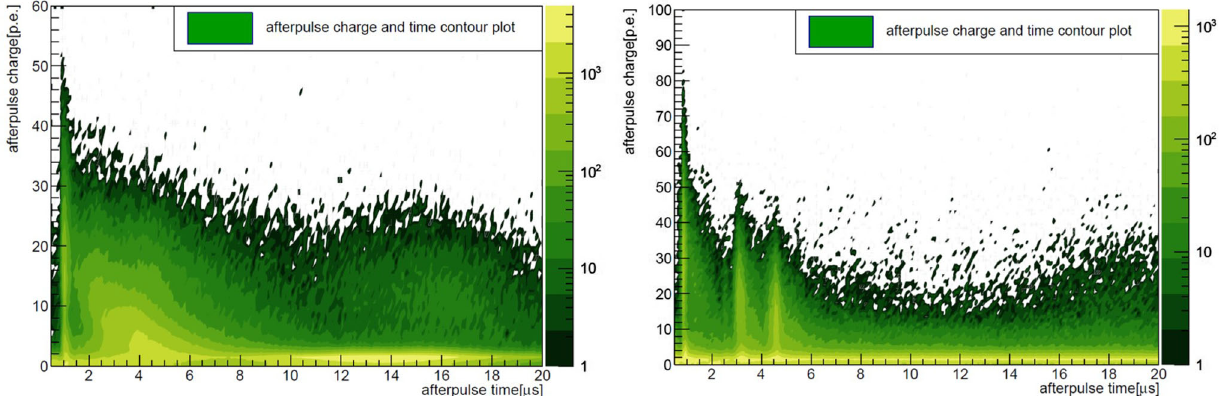
Fig. 30 The after-pulse intensity in p.e. versus time after the initial pulse. Left, HPK; Right, NNVT. The z-axis (color palette) presents the entries of the pulses with the same charge versus time The mean after-pulse charge ratio is calculated from 150 NNVT MCP-PMTs and 7 HPK dynode PMTs